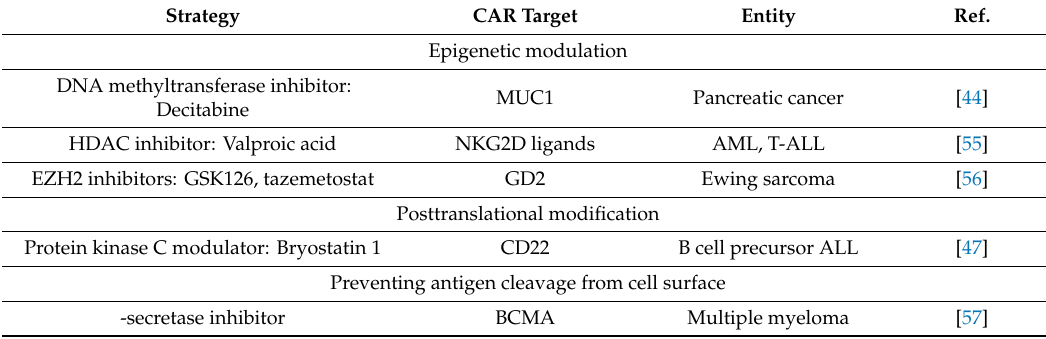
Table 1. Pharmaceutical strategies